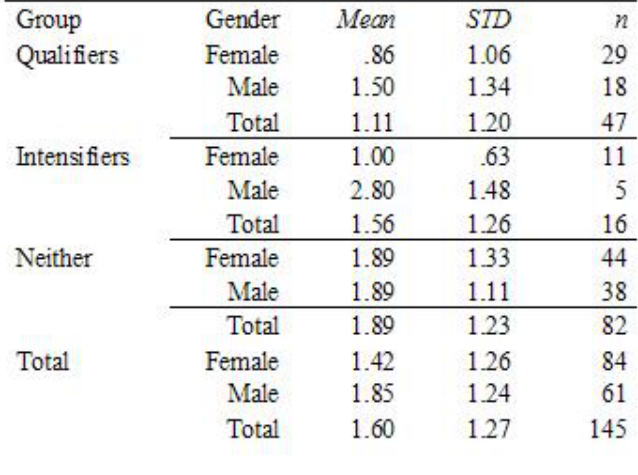
Table 2. Mean number of replies elicited by arguments presented by group and by gender